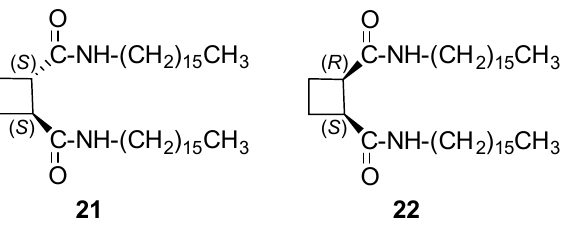
Figure 16. Cyclobutane-containing bisamide organogelators based on cyclobutane-1,2-dicarboxylic acid.